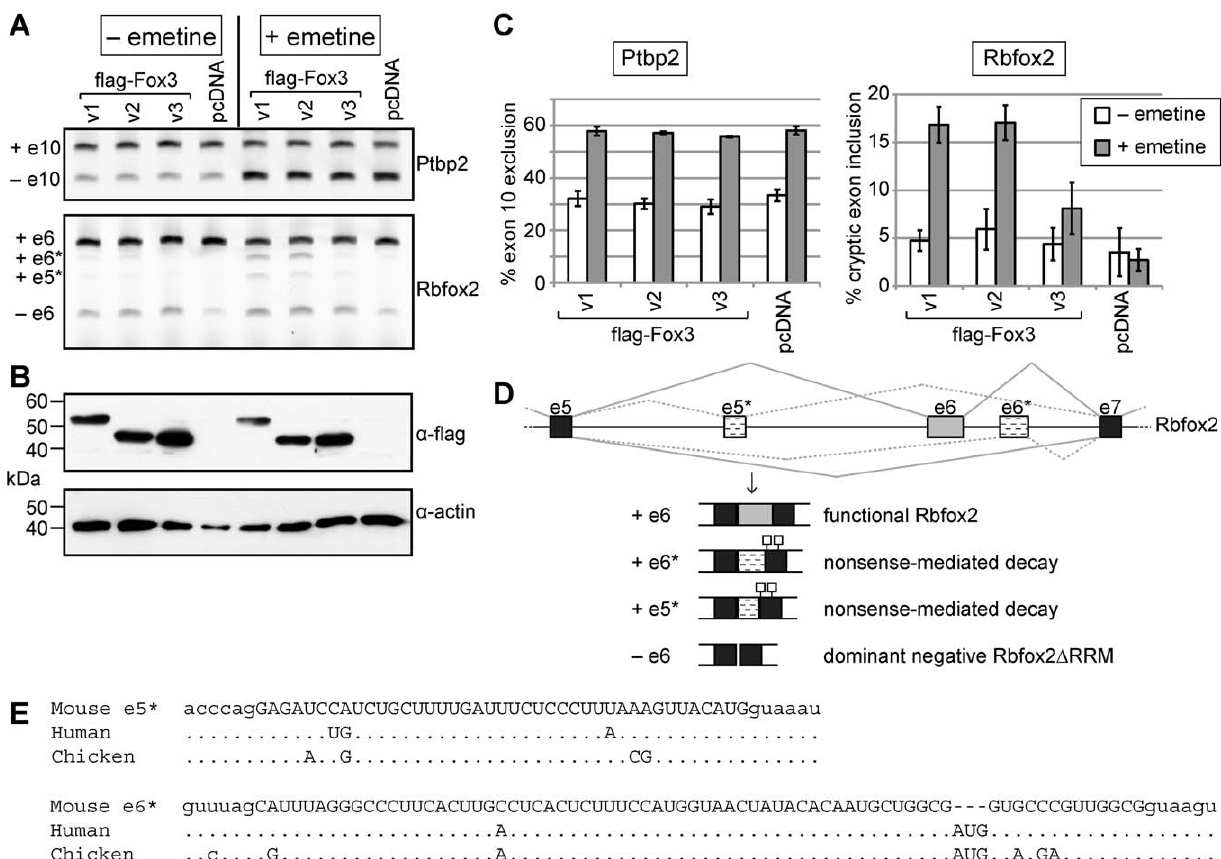
Figure 6. Rbfox3 variants enhance inclusion of cryptic exons in Rbfox2, leading to nonsense-mediated decay. N2A cells were transiently transfected with Rbfox3 variants 1, 2 or 3 harboring N-terminal flag-tags, or pcDNA3 vector control, and treated with emetine to inhibit NMD. A. Alternative splicing of endogenous mRNAs encoding Ptbp2 and Rbfox2 was assayed by RT-PCR. Enhanced exclusion of Ptbp2 exon 10 was used as a positive control for emetine treatment. Rbfox2 spliced products are described in D. B. Western with anti-flag was used to confirm Rbfox3 overexpression; anti-actin was used as a loading control. C. Quantification of the results shown in A and 2 additional experiments (i.e. n=3); results are displayed as average + / 2 standard deviation. D. Schematic representation of alternative splicing of the Rbfox2 message around exon 6, indicating the relative positions of cryptic exons 5* and 6*. The functional outcomes for the resulting spliced mRNA products are depicted below; inclusion of exon 5* or exon 6* results in the presence of 2 in-frame nonsense codons in exon 7, and destruction of these messages by nonsense-mediated decay. E. The sequences of mouse Rbfox2 exons 5* and 6* (upper case) and surrounding intronic sequence (lower case) are shown aligned to the corresponding regions from human and